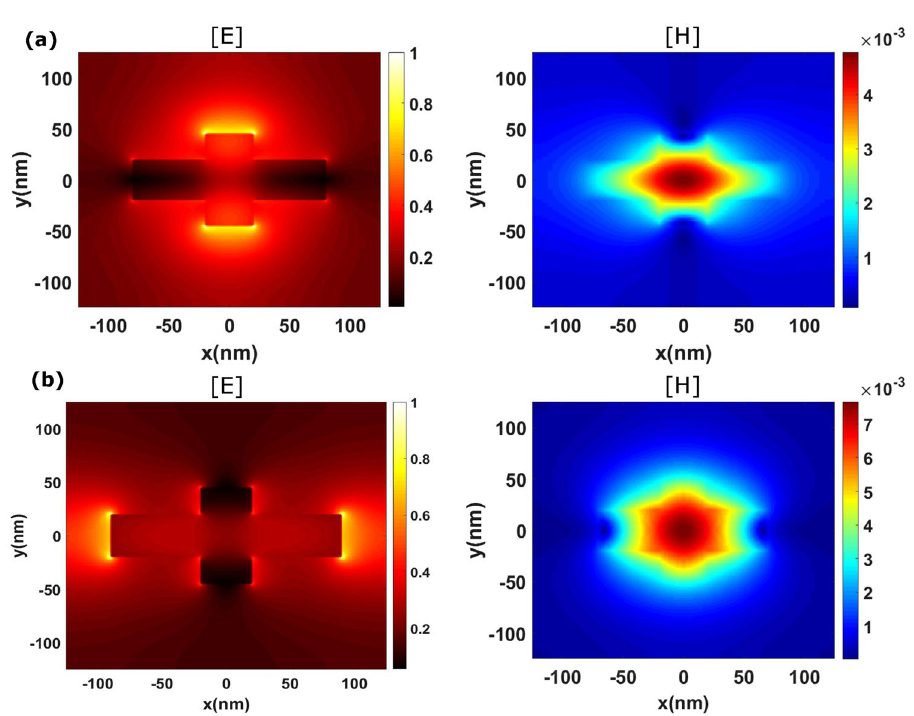
Figure 4. Electric and magnetic field distribution in ( x , y )-plane, at the mid-height of nanoantenna ( z = h /2): ( a ) λ = 480 nm, y -polarized incident wave and ( b ) λ = 570 nm, x -polarized incident